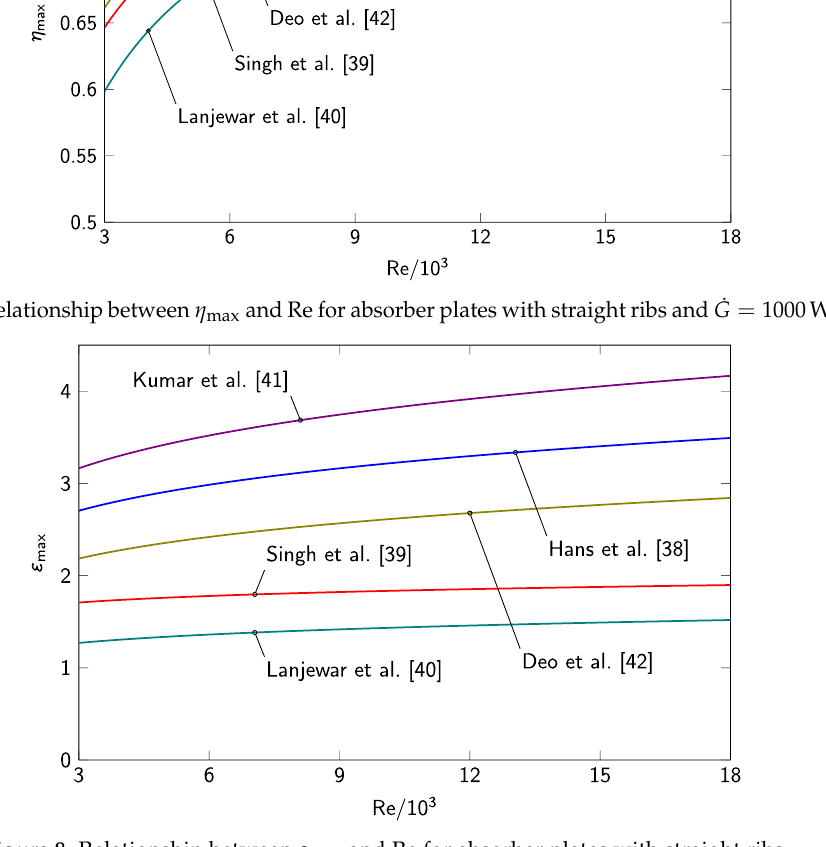
Figure 8. Relationship between ε max and Re for absorber plates with straight